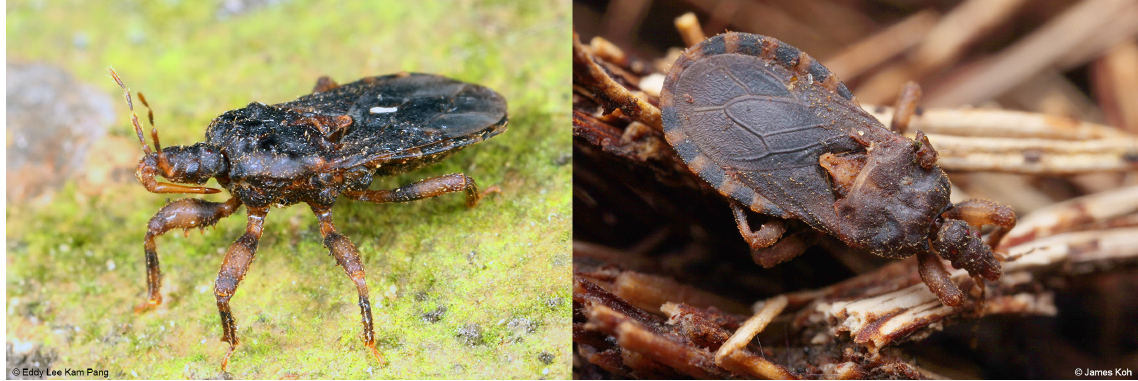
Fig. 1. In situ images of Physoderes curculionis China, 1936 in Singapore on mossy substrate (left) and vegetation debris